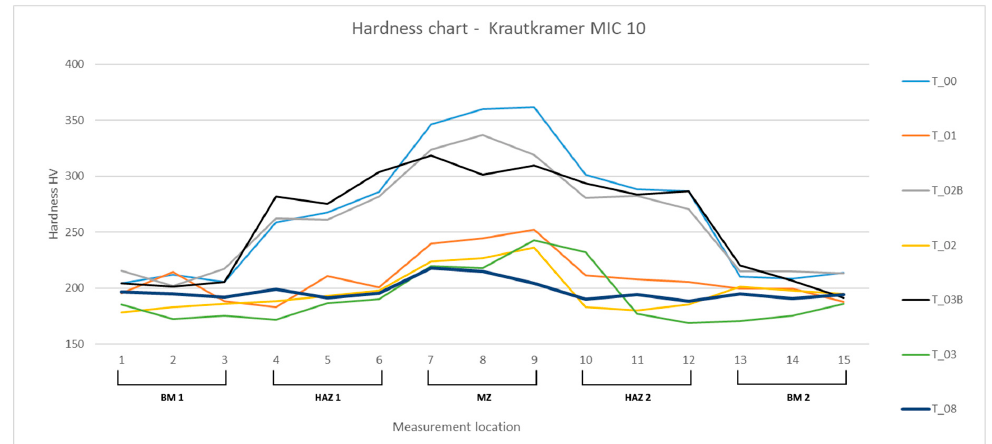
Figure 5. Hardness profile of the different samples across the welded and neighboring areas. The label B in some graphs represents the values obtained before the PWHT was carried out 6 months after the welding. Metals 2020 , 10 , x FOR PEER REVIEW